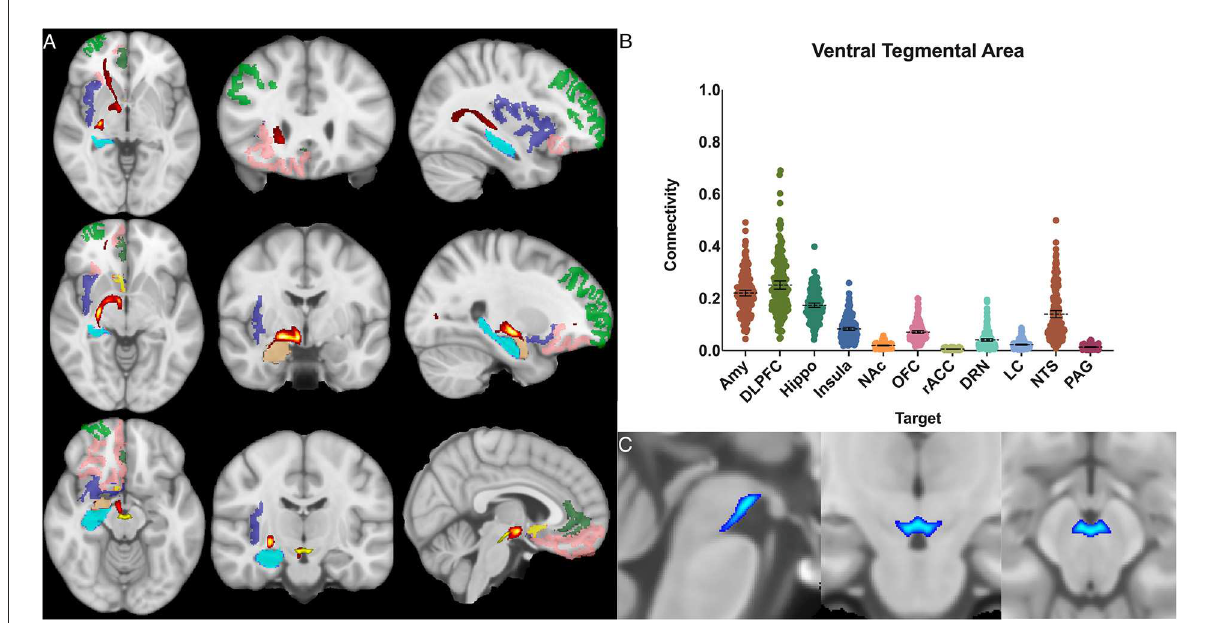
FIGURE7 Periaqueductal grey structural connectivity. (A) MNI space structural connectivity results visual representation averaged over all 197 subjects. Brighter yellow on heat map indicates a high number of samples passing through a given point that will eventually reach a target map (brighter yellow = more samples). Dark green: DLPFC; pink: OFC; brown: AMY; blue: HIPPO; purple: insula; orange: NAc; light green: rACC. (B) Mean connectivity results with dashed line showing mean and 95% CI, each point on graph shows result from individual subject. (C) Anatomic MNI mask of seed region.